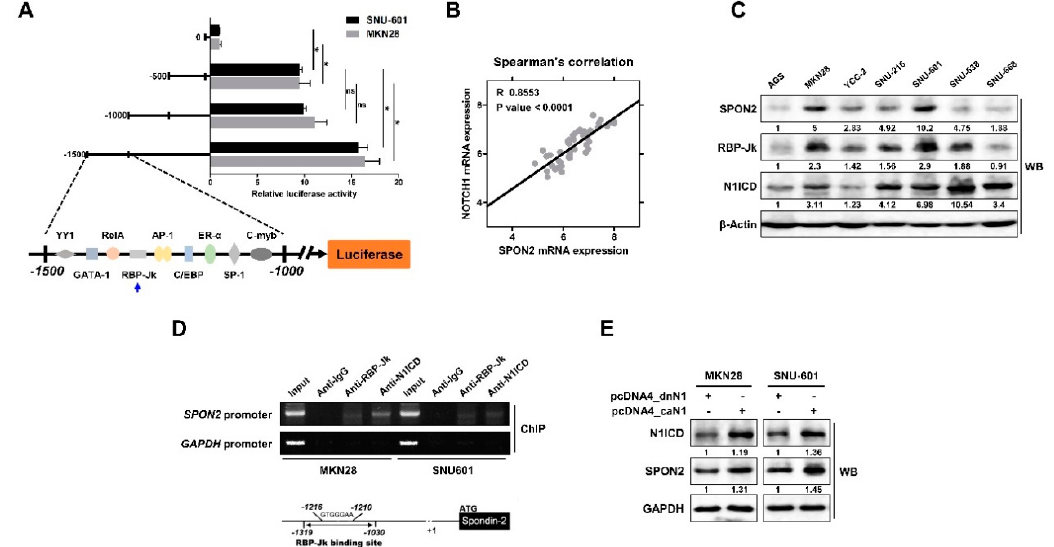
Figure 5. SPON2 expression is regulated by Notch signaling pathway. ( A ) MKN28 and SNU-601 cells were transfected with pGL3-luciferase vector containing SPON2 promoter binding motifs. Activity